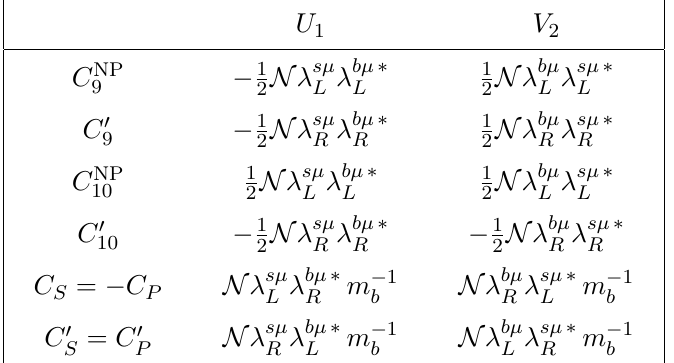
Table 2 . The bs(cid:22)(cid:22) Wilson coe(cid:14)cients in the two LQ models in terms of mass-basis couplings. The superscript \NP" denotes the new physics contribution. The normalization factor in